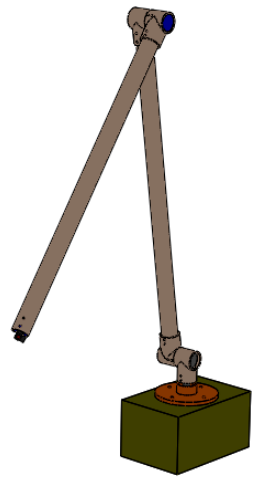
Figure 3. Anthropomorphic mechanism of 3 DOF for position detection.